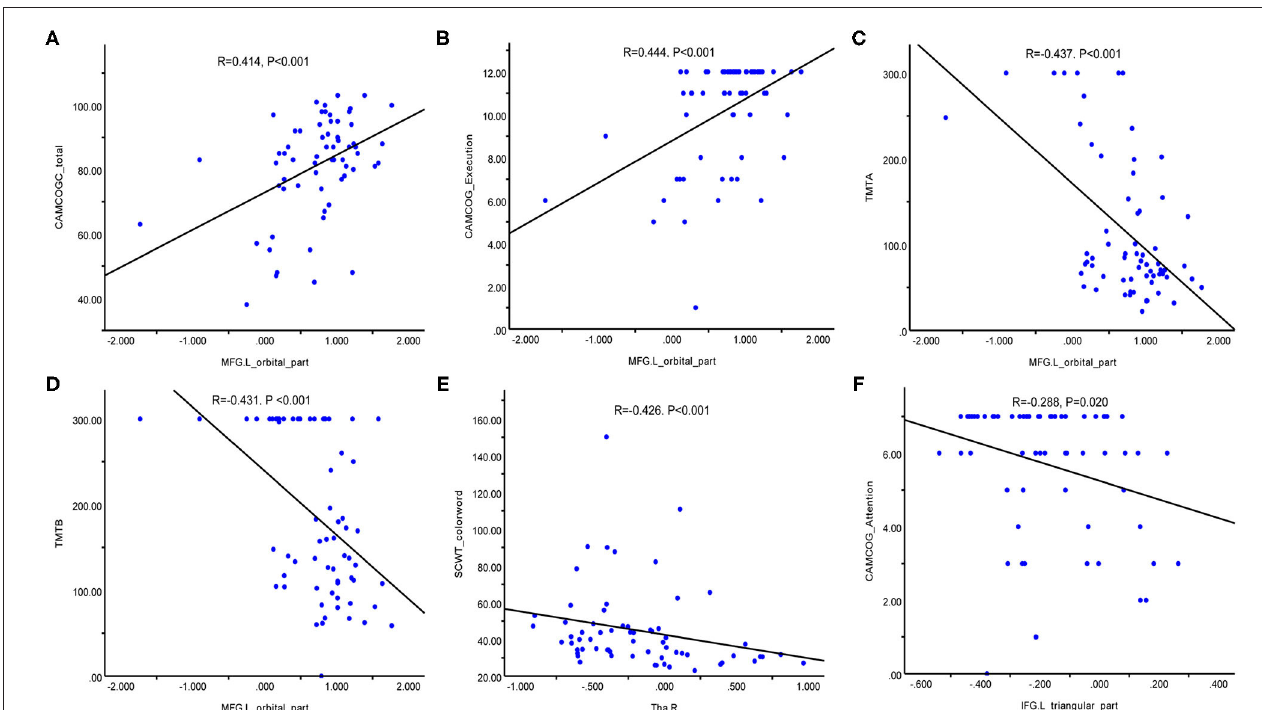
FIGURE 3 | Correlation between CBF in regions of interest and neuropsychological test results in patients with WMHs. (A) Positive correlation between MFG.L (orbital part) CBF values and the CAMCOG-C total scores. (B) Positive correlation between MFG.L (orbital part) CBF and execution based on the CAMCOG-C scores. (C) Negative correlation between MFG.L (orbital part) CBF values and TMT-A scores. (D) Negative correlation between MFG.L (orbital part) CBF values and TMT-B scores. (E) Negative correlation between Tha.R CBF values and SCWT-C scores. (F) Negative correlation between IFG.L (triangular part) CBF values and attention based on the CAMCOG-C scores. CBF, cerebral blood flow; MFG.L (orbital part), left orbital medial frontal gyrus; Tha.R, right thalamus; IFG.L (triangular part), left triangular inferior frontal gyrus; CAMCOG-C, Cambridge Cognitive Examination-Chinese Version; TMT, trail making test; SCWT, Stroop color word